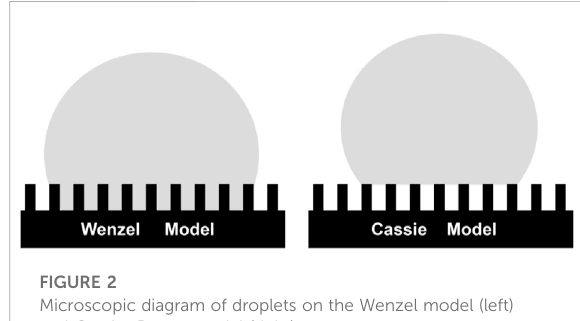
FIGURE 2 Microscopic diagram of droplets on the Wenzel model (left) and Cassie – Baxter model